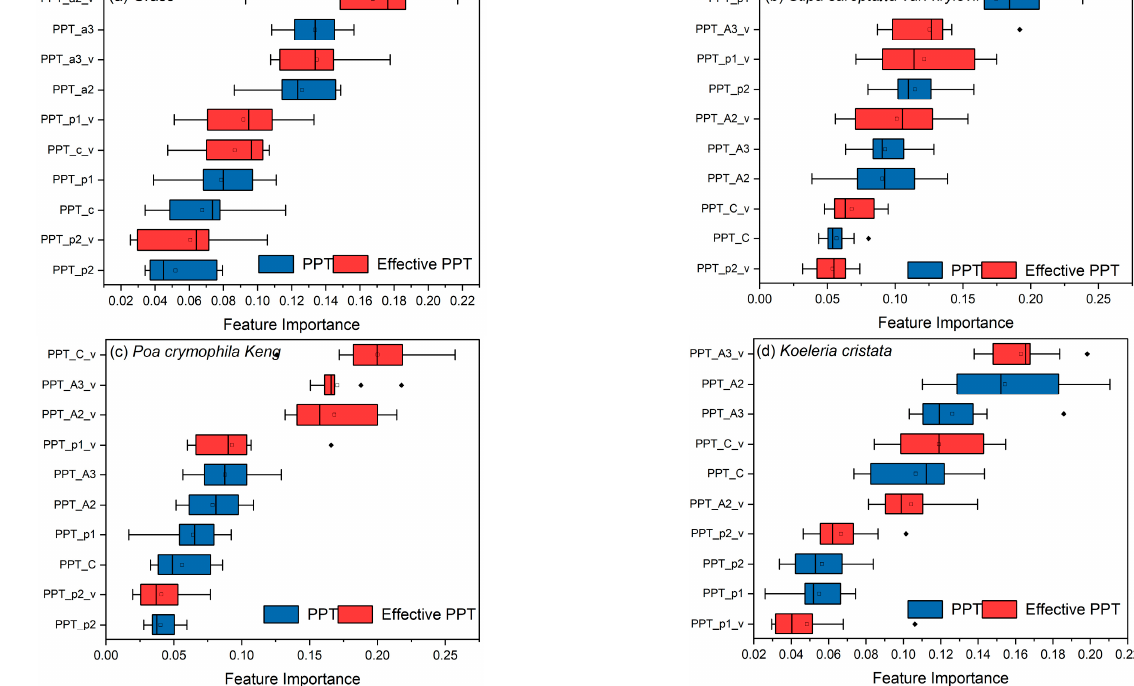
Figure 5. Random Forest Feature importance for Multi-species biomass (( a ): Grass; ( b ): Stipa sareptana var. krylovii ; ( c ): Poa crymophila Keng; ( d ): Koeleria cristata ) during 1997–2011.